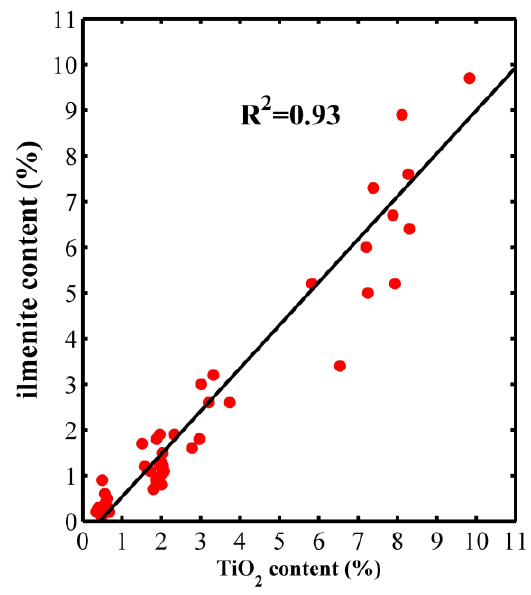
Remote Sens. 2020 , 12 , x FOR PEER REVIEW Figure 9. Linear correlation between ilmenite content and TiO 2 content of lunar soil samples.